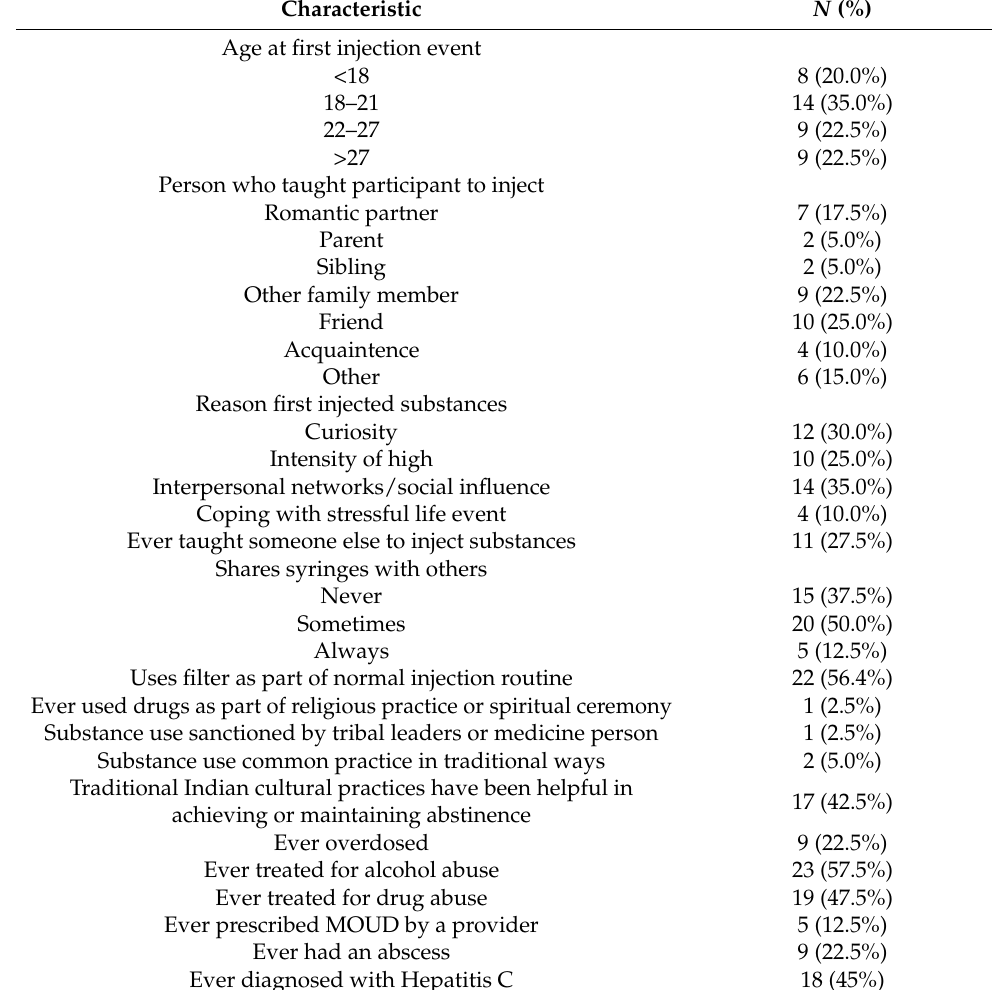
Table 2. Injection drug use and general health characteristics of participants, n =